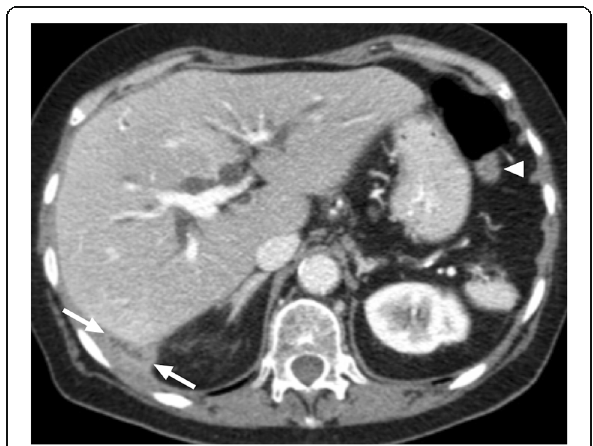
Fig. 22 A 65-year-old male with a history of colon cancer in remission for 7 years underwent a follow up CT. He was completely asymptomatic at the time of the CT scan. He also has a remote history of laparoscopic cholecystectomy 5 years before. Axial plane postcontrast CT image demonstrates a complex looking cystic mass in the liver capsule (arrows) suggestive for a tumor implant. Also note is made of a small solid nodule in the left upper quadrant (arrowhead). Surgical excision confirmed